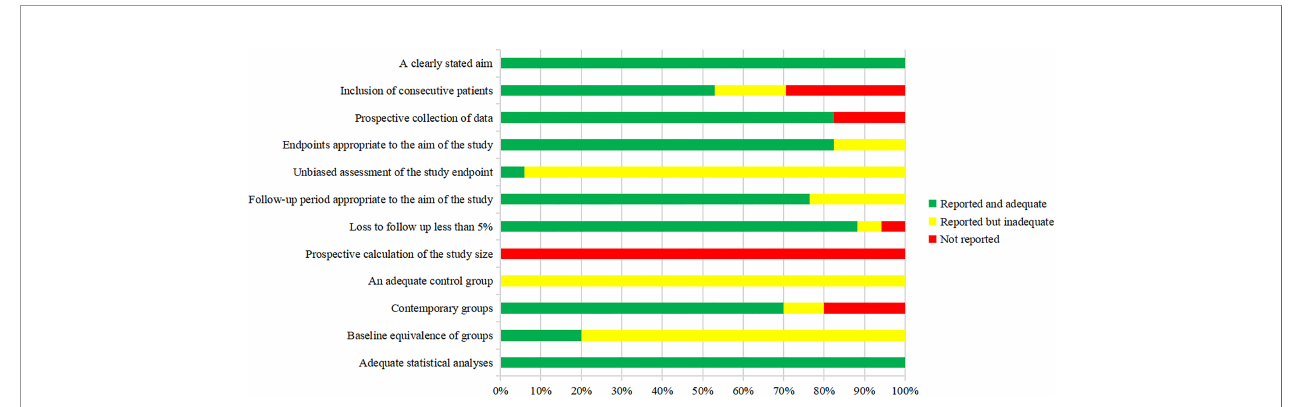
FIGURE 3 | Risk of bias across studies assessed using the MINORS